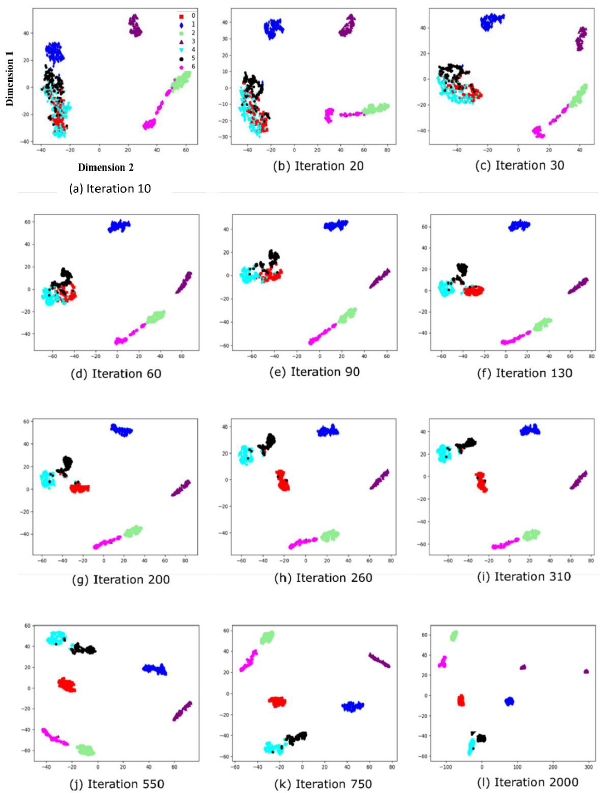
Figure 8. Training process of the 1D-CNN: Comparison of different number of iterations, from 10 to 2000. 3.2. Number of Classes and Generalization Table 6 shows 1D-CNN performance at different number of classes. In Table 6, it can